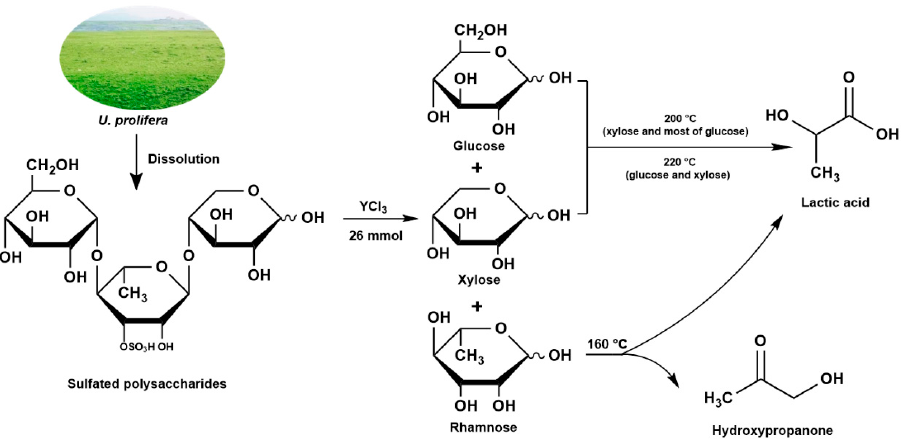
Figure 5. Proposed schematic reaction pathway for the conversion of polysaccharides in U. prolifera.